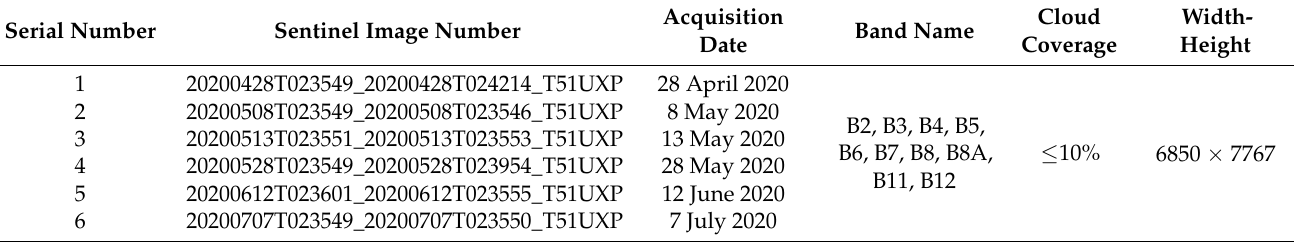
Table 2. Image data was used in this